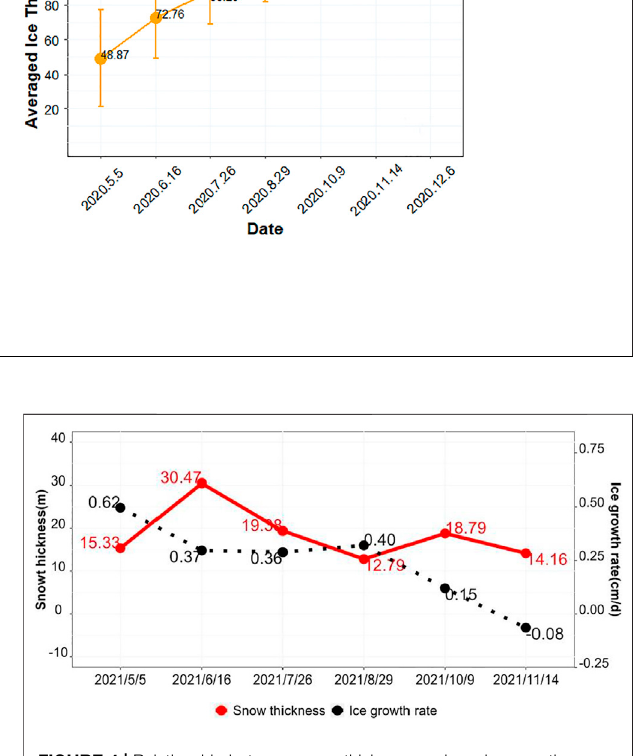
effect on the heat exchange between sea ice and the atmosphere.